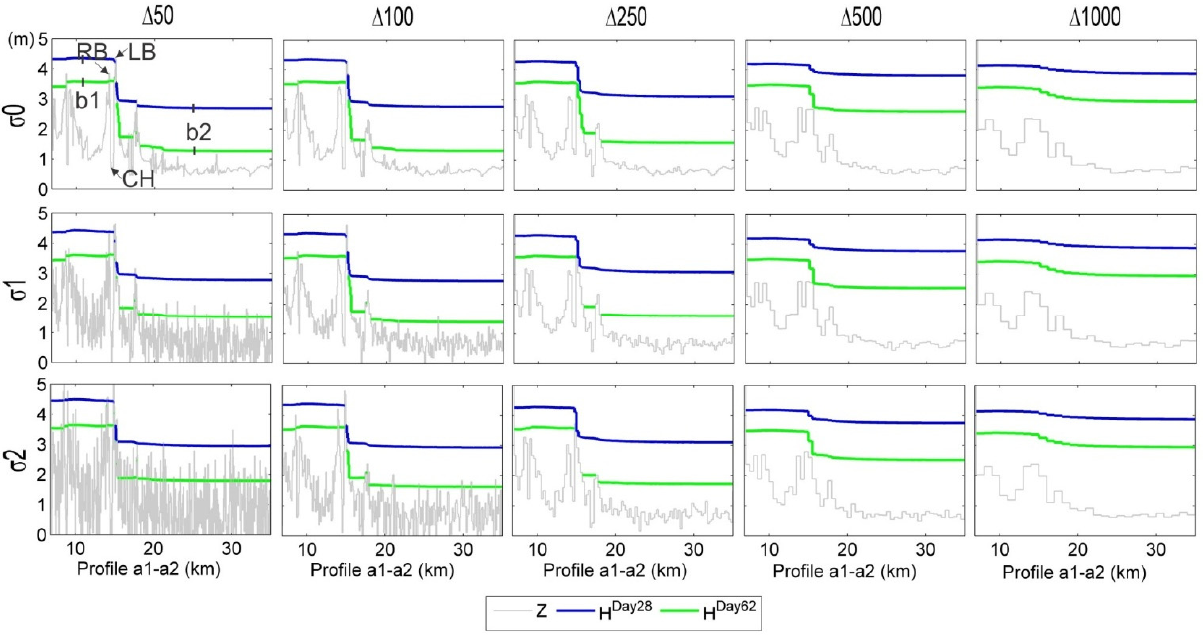
Figure 4. Profiles of water elevations (H) along profile a1-a2 in Figure 3 on both high water (day 28) and low water (day 62) and floodplain elevations (Z) from the 15 different models. The left and right banks (LB, RB) are separated by the main channel located at ~15 km on the profile